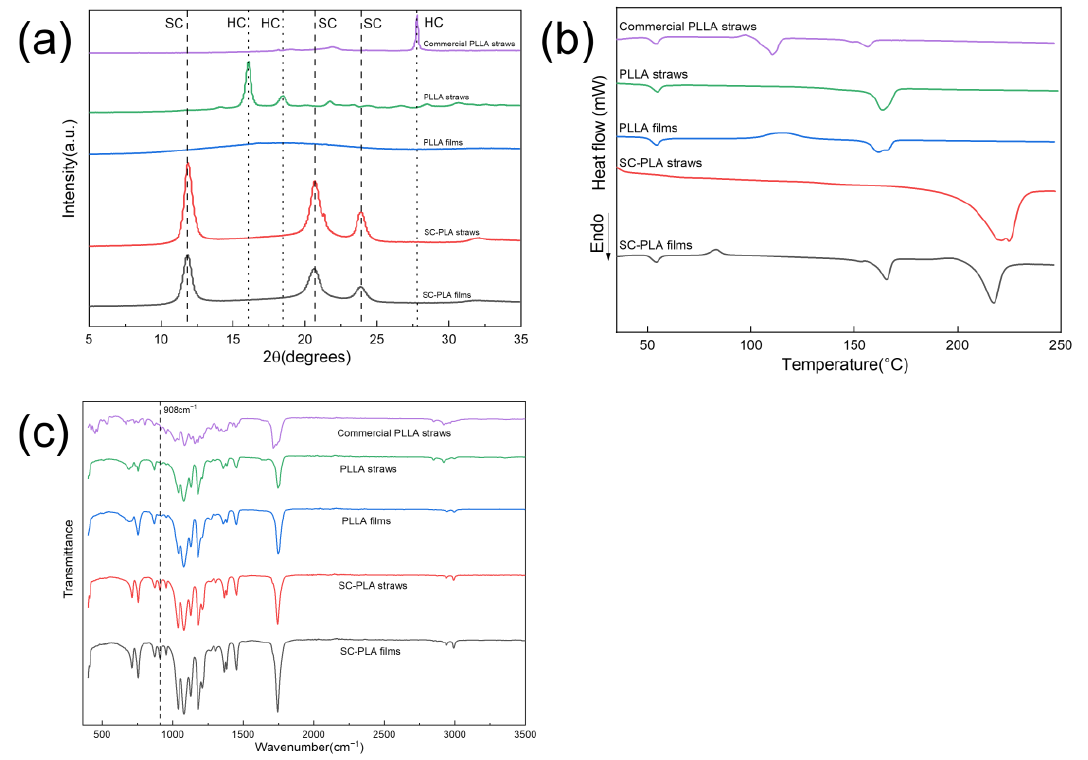
Figure 2. Comparison of crystallisation and thermal behaviour of films and straws. ( a ) XRD patterns, ( b ) DSC diagram, and ( c ) FTIR spectrum. Table 1. Average thermal values of films and straws; three tests were performed for each group.